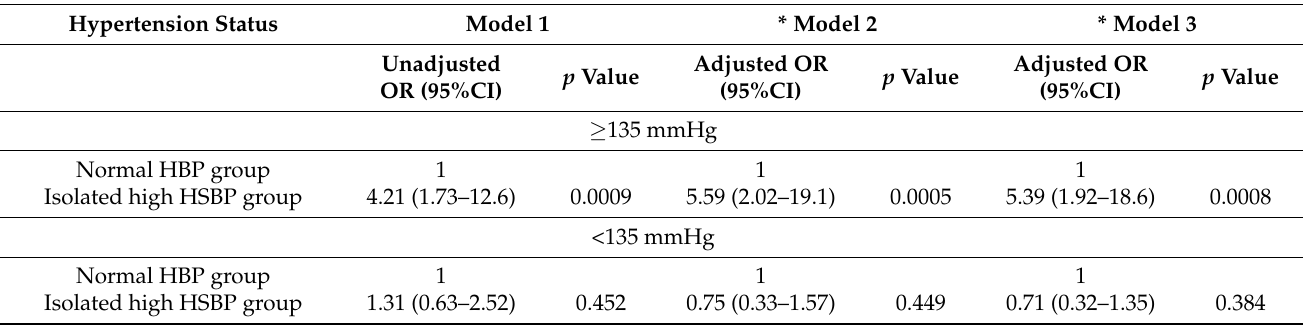
Table 5. Unadjusted and adjusted odds ratios for the development of diabetic nephropathy in patients according to systolic blood